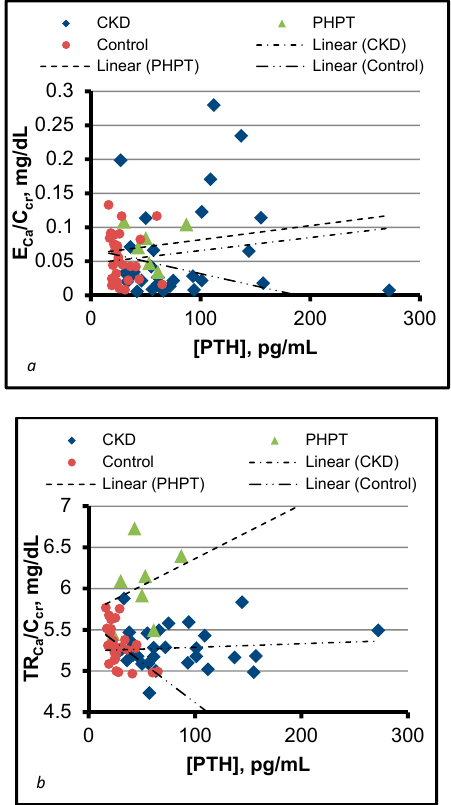
Figure 1. Plots of E Ca /C cr and TR Ca /C cr against [PTH] in control subjects and patients with primary and secondary hyperparathyroidism (PHPT and SHPT). All data are derived from morning fasting specimens of urine and serum or plasma. Circles represent normal controls. Triangles and diamonds represent patients with PHPT and SHPT (CKD), respectively. Frame ( a ) shows that the lowest recorded values of E Ca /C cr in controls were compatible with normal [PTH]. It also shows that a minority of patients with CKD exhibited high E Ca /C cr and high [PTH] simultaneously. Frame ( b ) shows that [PTH] capable of causing high TR Ca /C cr in patients with PHPT maintained normal TR Ca /C cr in patients with CKD. Reproduced from [16] with permission of the publisher (Dustri- Verlag). E Ca , Urinary excretion rate of calcium, mass/time; C cr , Creatinine clearance (volume/time); TR Ca , Rate of tubular reabsorption of calcium, mass/time; PTH, Parathyroid hormone; CKD, Chronic kidney disease.